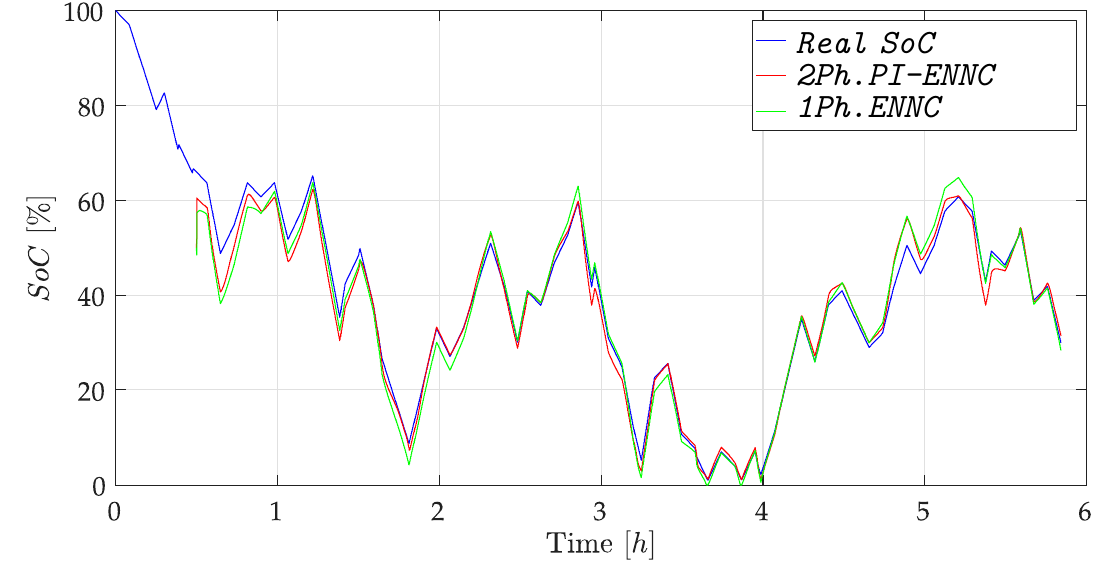
Figure A1. Comparison of the ENNC and PI-ENNC SoC prediction time series on the test set referring to the NASA